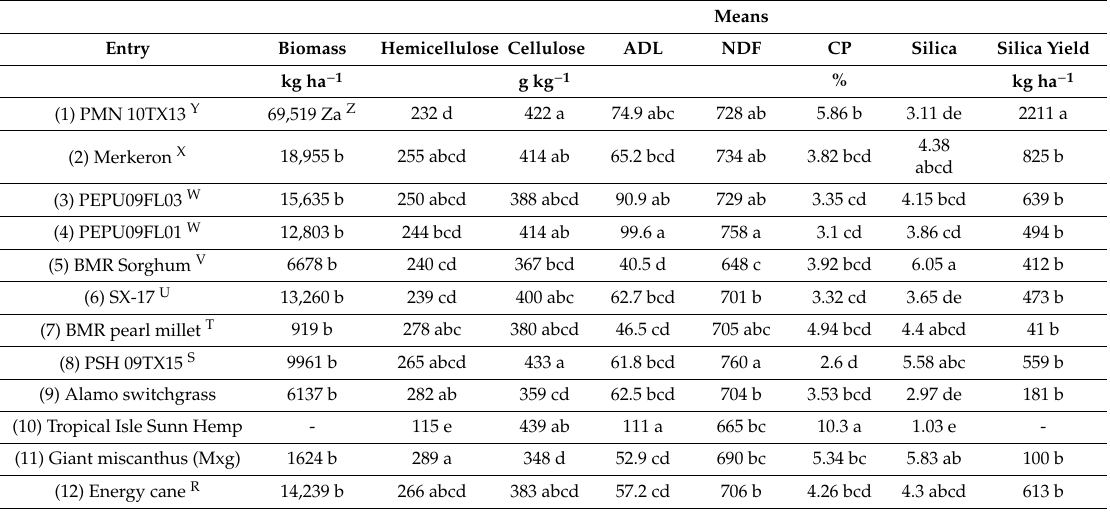
Table 5. First year Beeville sample traits of biomass yield (kg ha − 1 ) and chemical composition including hemicellulose, cellulose, acid detergent lignin (ADL), neutral detergent fiber (NDF) (g kg − 1 biomass), crude protein (CP) (%), silica (%), and silica yield (kg ha − 1